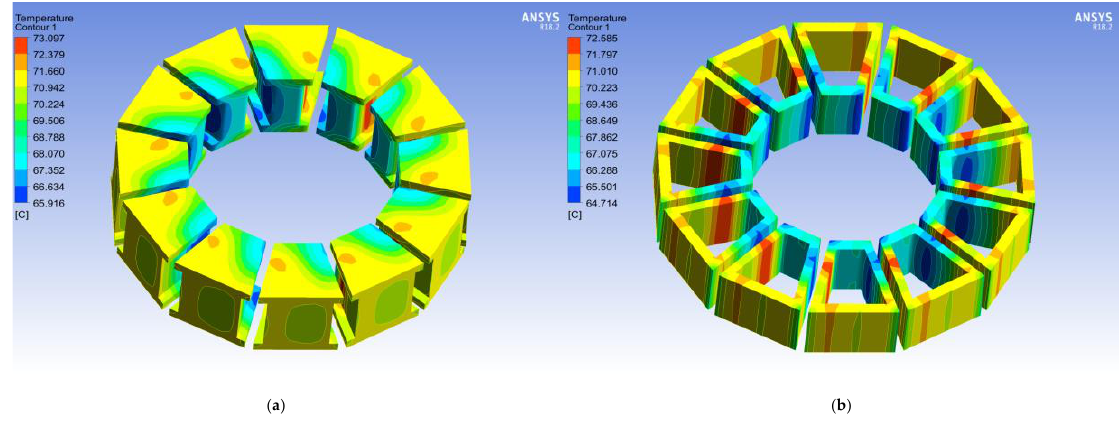
Figure 12. Temperature distribution with the stator of the YASA machine. ( a ) Temperature of stator cores. ( b ) Temperature of windings.